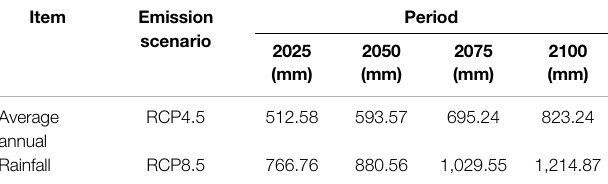
TABLE 1 | Average annual rainfall under various periods and scenarios.